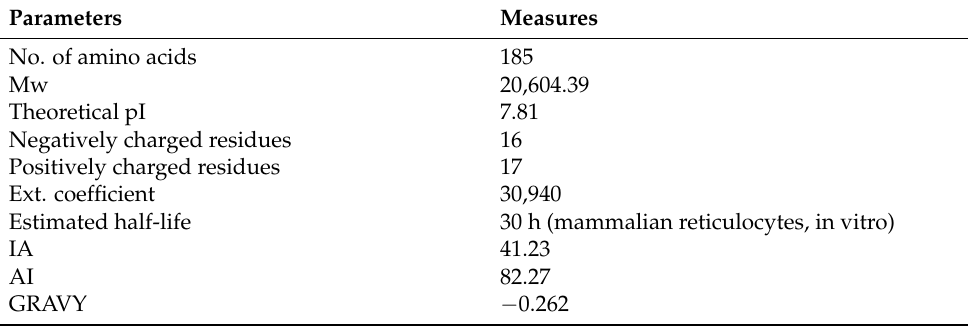
Table 1. Physical and chemical characteristics of chromate reductase.